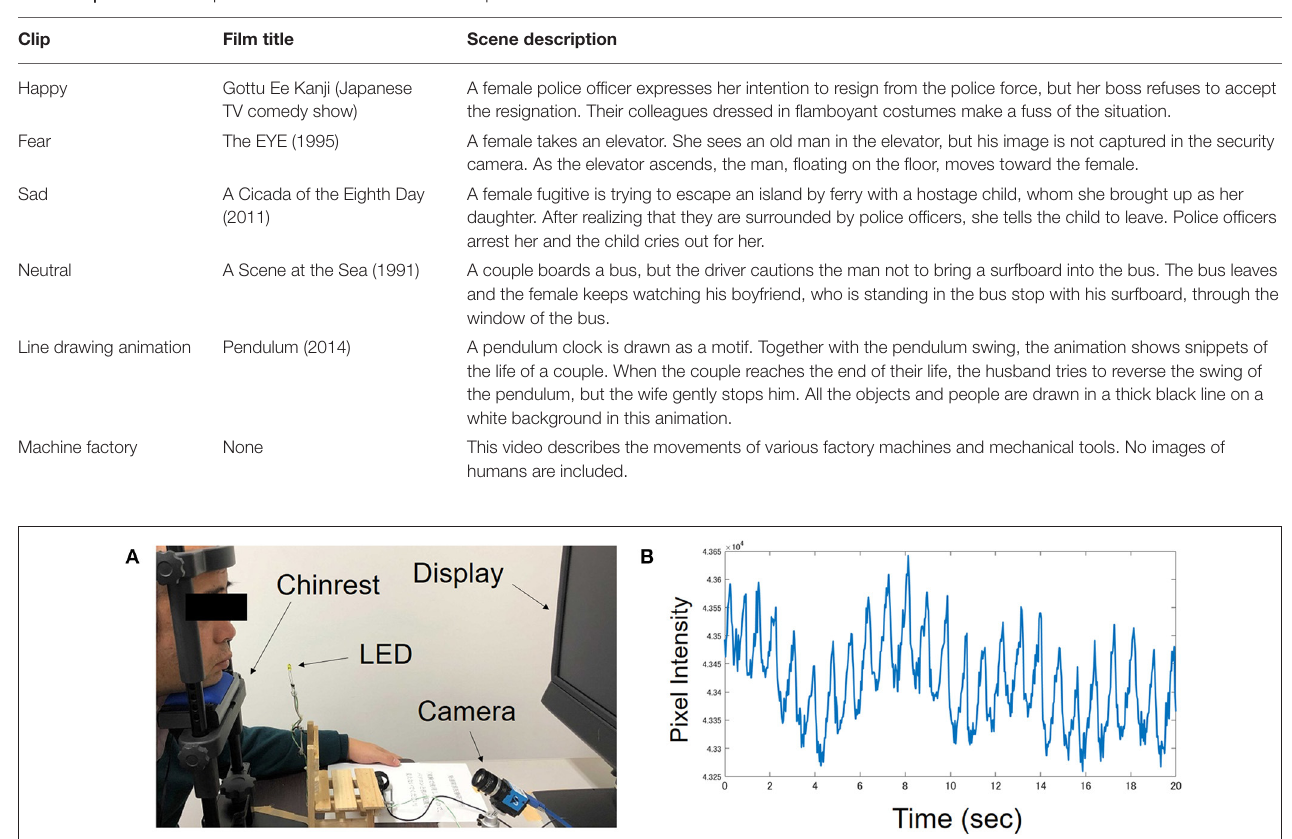
TABLE 1 | Detailed descriptions of scenes in stimulus video